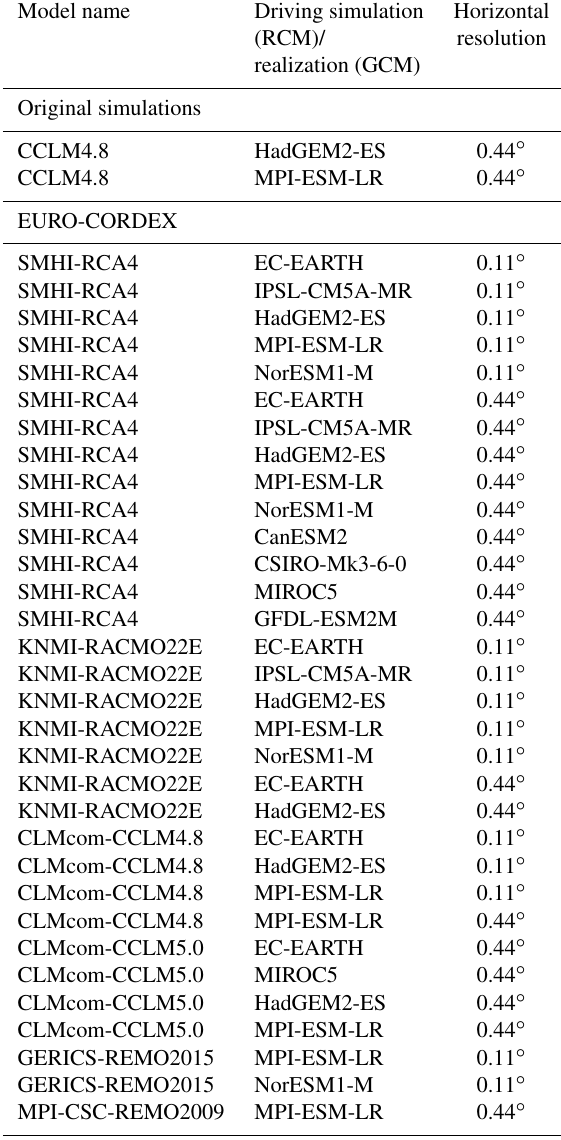
Table A1. Simulations used for analysis. The original simulations are regional climate modeling (RCM) experiments as described in Sect. 2.2, and the additional RCM simulations are from the EURO- CORDEX ensemble. Furthermore, global climate (GCM) simula- tions from the CMIP6 ensemble are used. Columns show the model name, the global driving simulation for RCMs, the realization for GCMs, and the horizontal resolution of the atmospheric